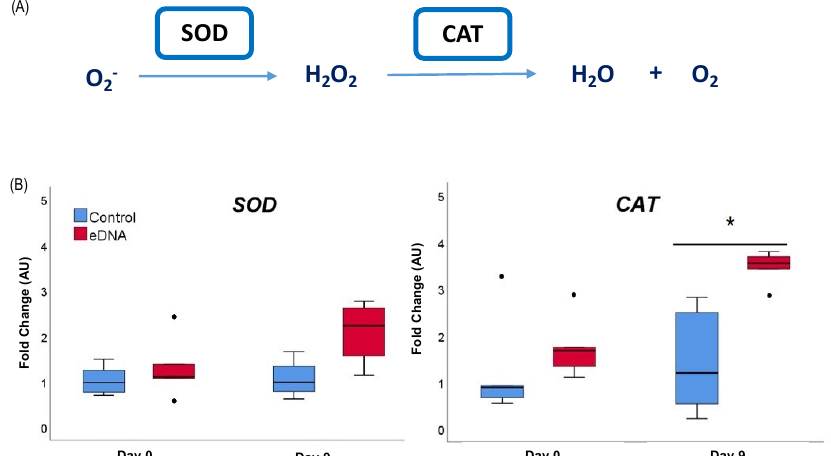
of the CAT gene but not the SOD gene (Figure 4B).